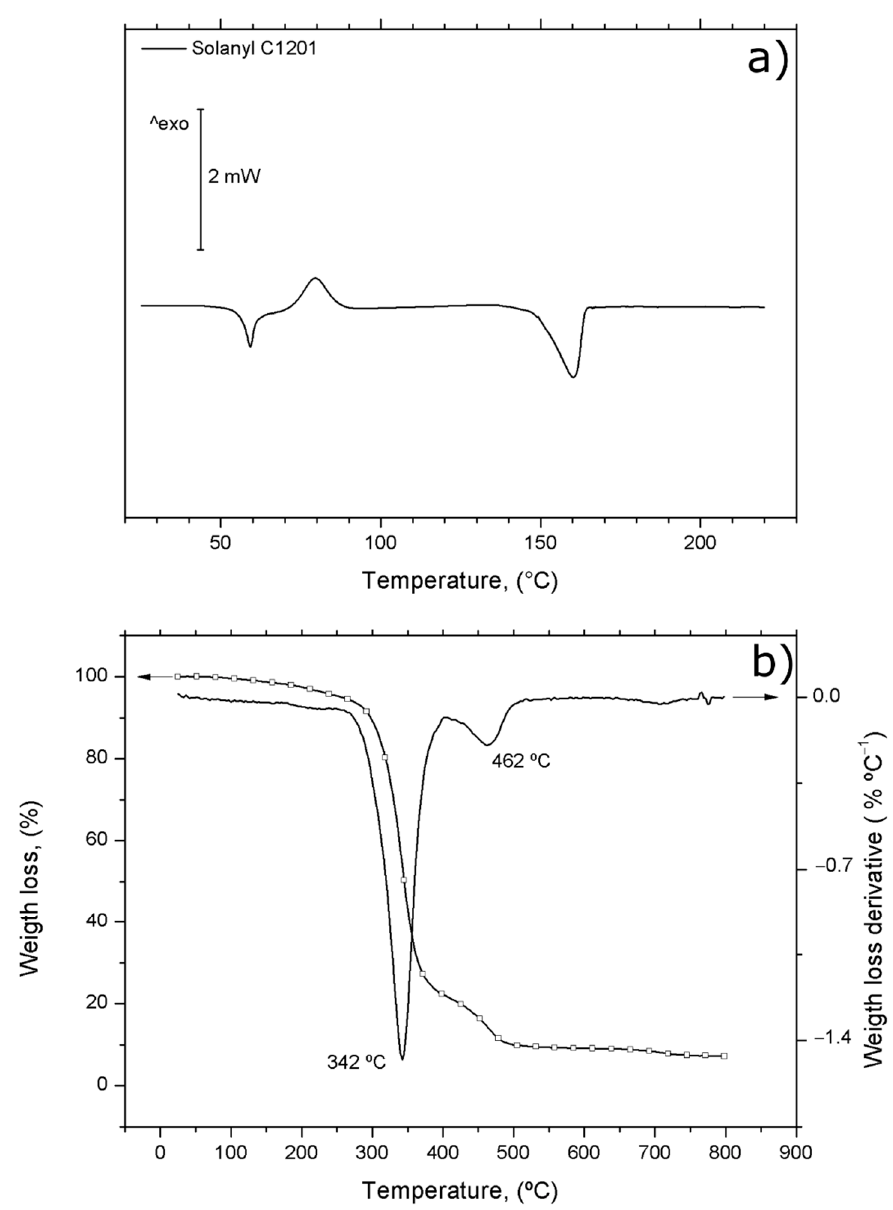
Figure 14. ( a ) DSC curve analysis of Solanyl ® C1201, ( b ) TGA and DTGA curves of Solanyl ® C1201.